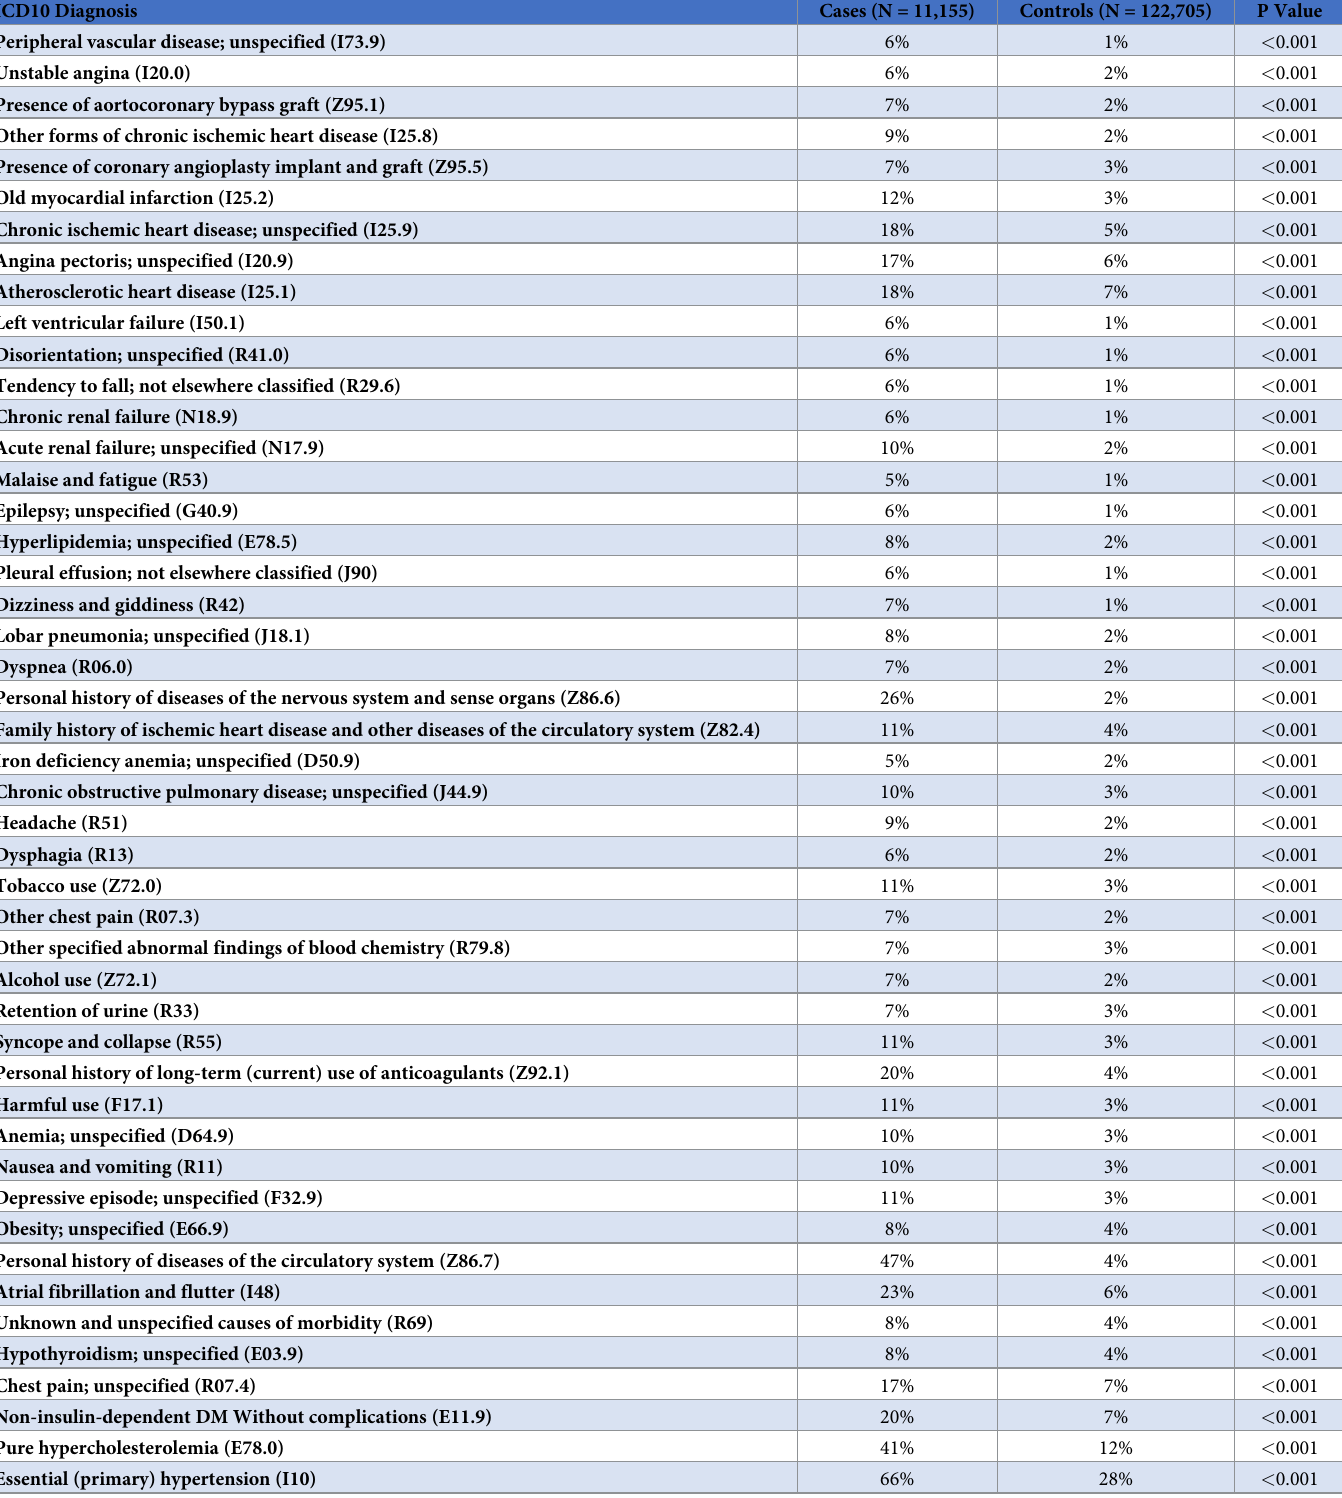
Table 4. Relevant ICD10 diagnoses associated with cerebrovascular disease